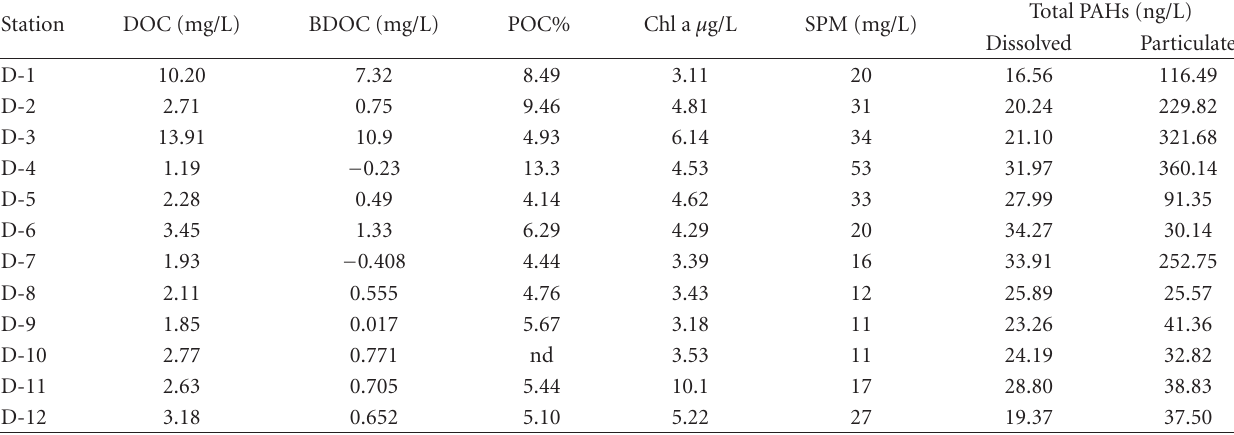
Table 1: Major aquatic chemical properties of the water samples collected from Dongjiang River in July 2010. Station